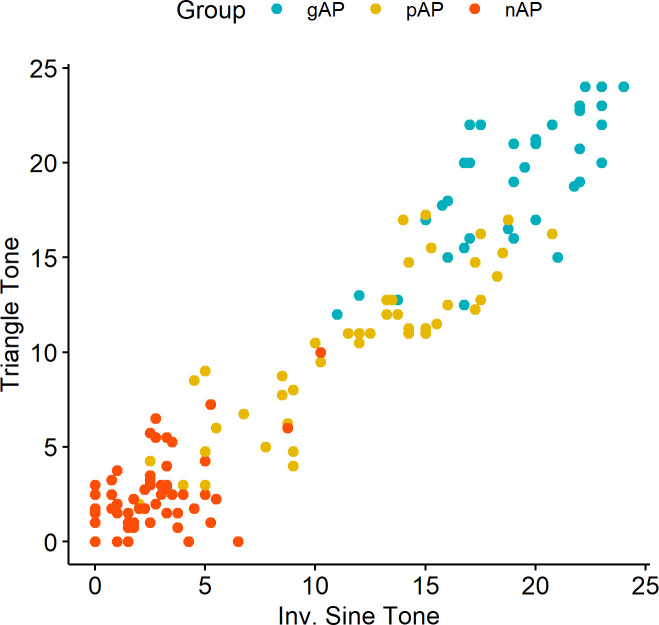
Scatterplot of performance on the inverted sine (x) and triangle (y) tones, using the conservative scoring measure.The three groups–genuine AP (gAP), pseudo AP (pAP), and non-AP (nAP) are carried over from the determination made using the composite measure.